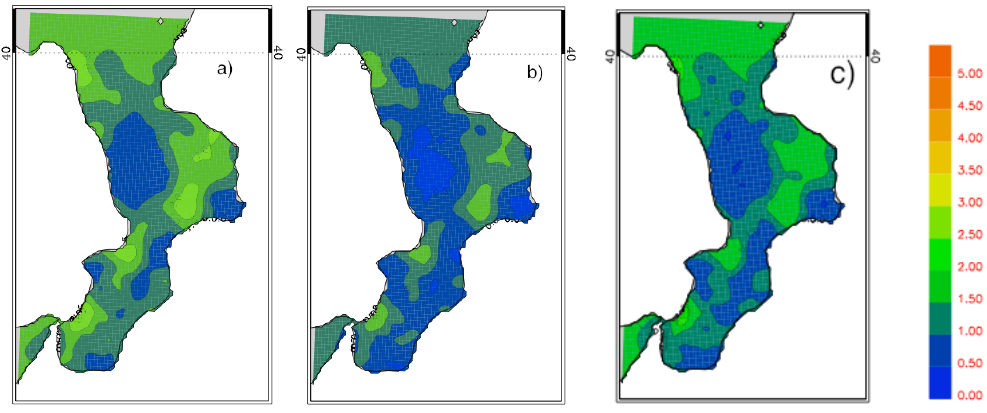
Fig. 5. OI analysis variance for minimum (panel a ), mean (panel b ) and maximum (panel c ) temperature averaged over the whole